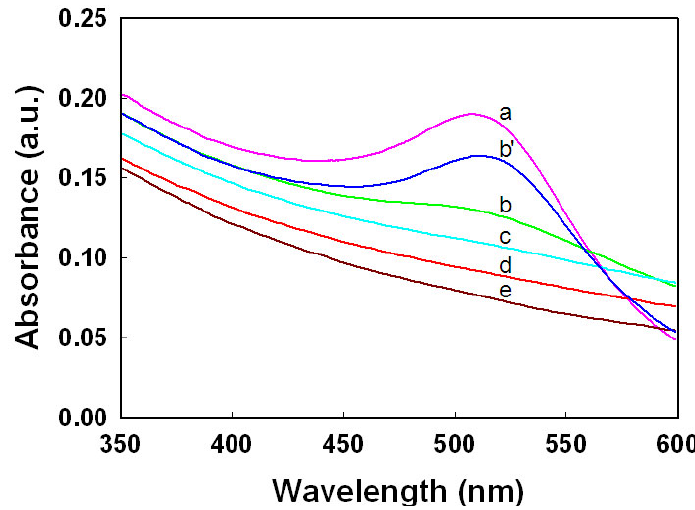
Figure 2. UV-vis absorption spectra for various metal NPs @ TOCN composites with molar ratios of Au:Pd = ( a ) 1:0; ( b ) 3:1; ( c ) 1:1; ( d ) 1:3 and ( e ) 0:1; ( b ') a physical mixture of AuNPs @ TOCN and PdNPs @ TOCN with a molar ratio of Au:Pd =